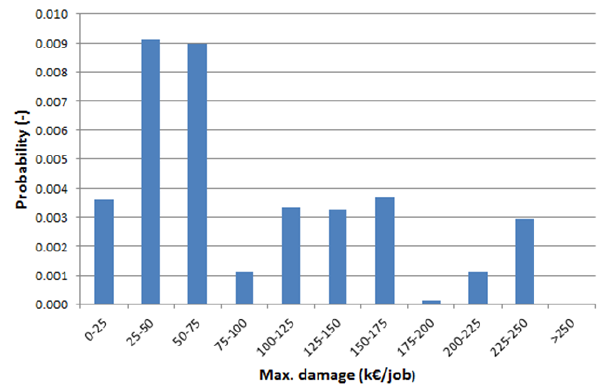
Figure 3. Probability of different maximum damages as it was used in the calculation. This is based on a study of Gauderis (2012) who calculated the damage for 62 different company types in the Nether- lands. Data about how frequently these company types occur in the Netherlands are used to make this estimate of the probability den- sity of the maximum damage per job in the